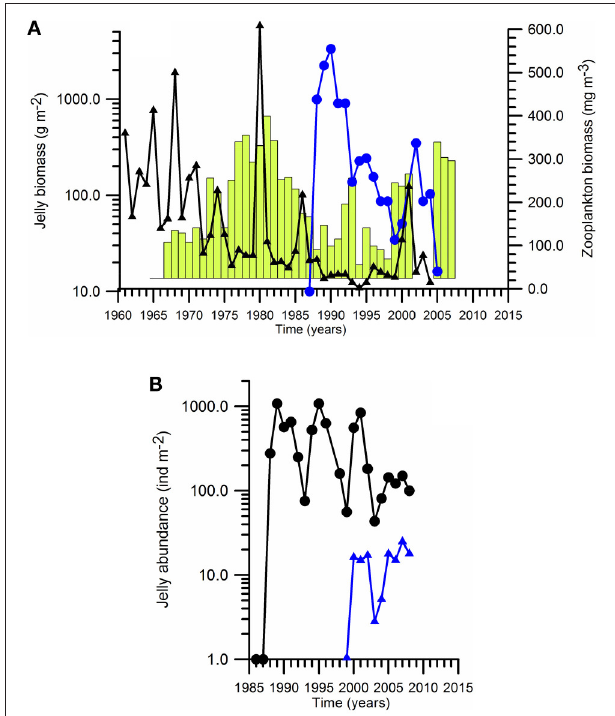
FIGURE 5 | Long-term biomass changes of (A) Aurelia biomass (vertical bars), Mnemiopsis biomass ( • ) and edible zooplankton biomass ( N ), and (B) Mnemiopsis abundance in August ( • ) and Beroe abundance in September ( N ) in the northeastern shelf-slope